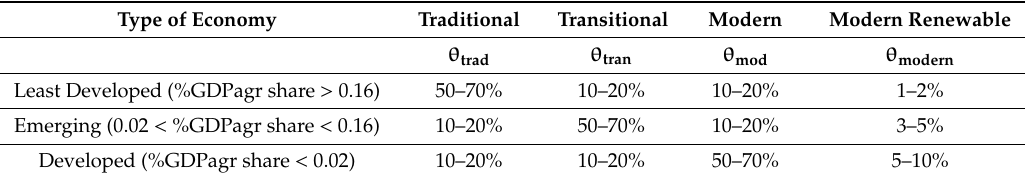
Table A1. Mechanisation share lower and upper bounds assumptions for di ff erent type of economies [59]. Type of Economy Traditional Transitional Modern Modern Renewable θ trad θ tran θ mod θ modern Least Developed (%GDPagr share > 0.16) 50–70% 10–20% 10–20% 1–2% Emerging (0.02 < %GDPagr share < 0.16) 10–20%